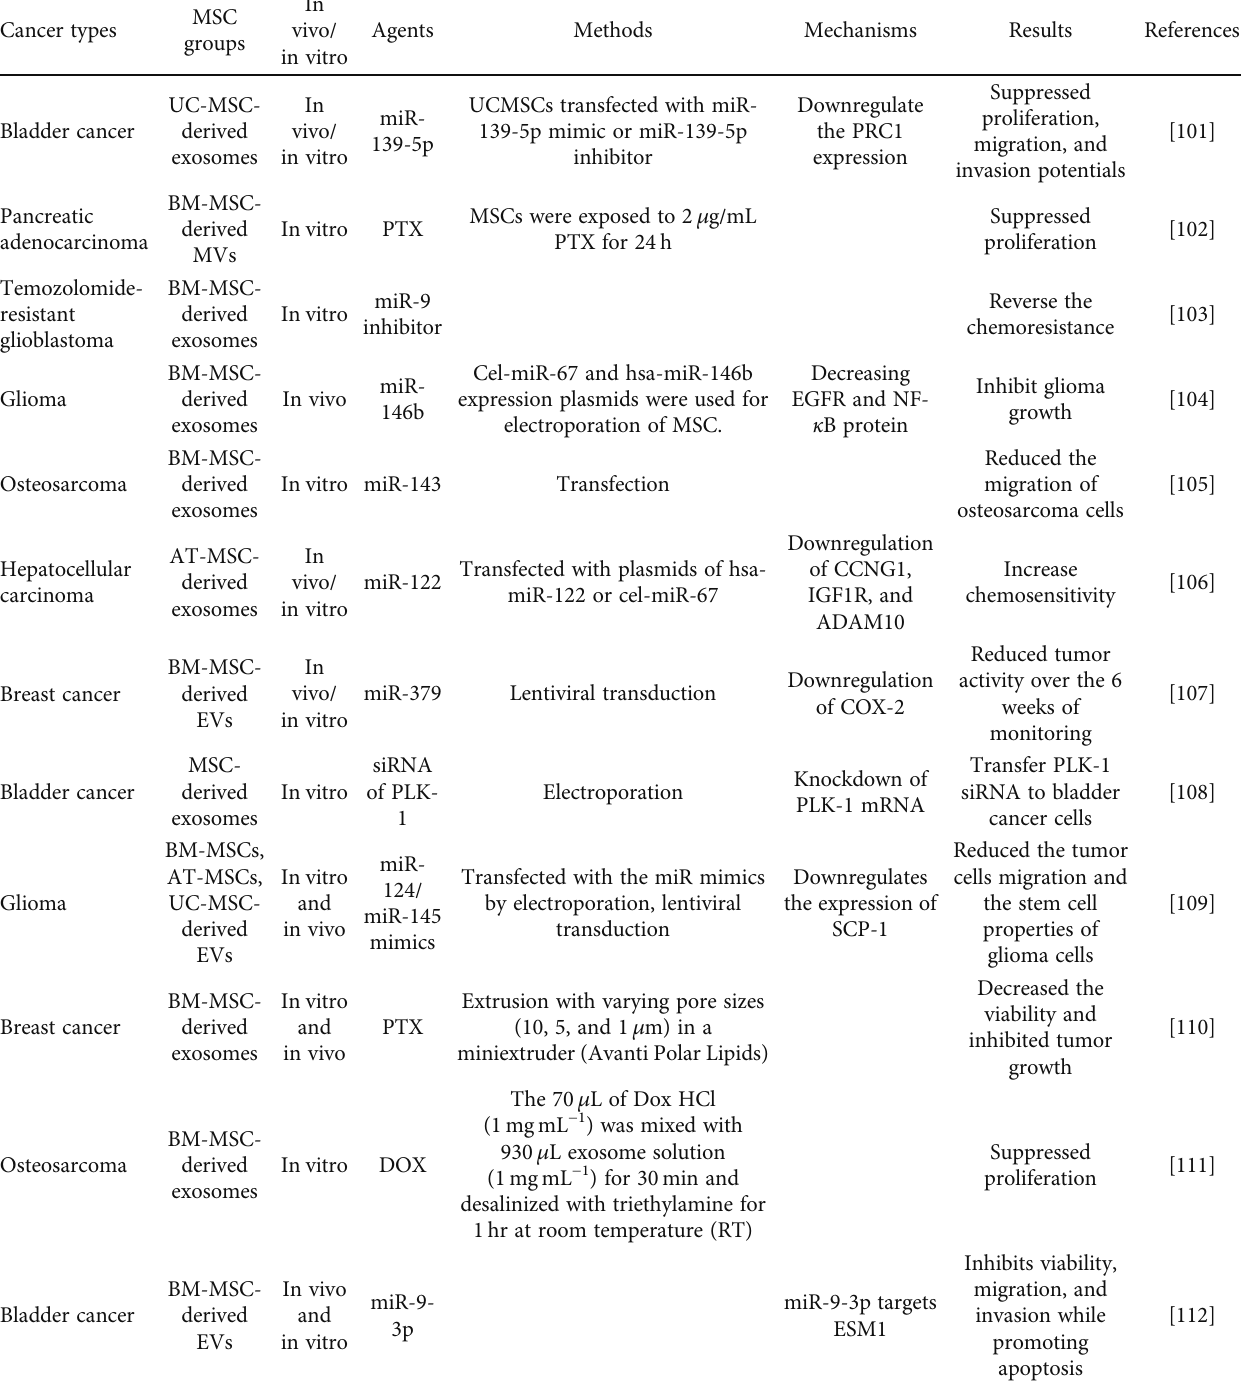
Table 6: Extracellular vesicles and exosomes derived from MSCs as antitumor